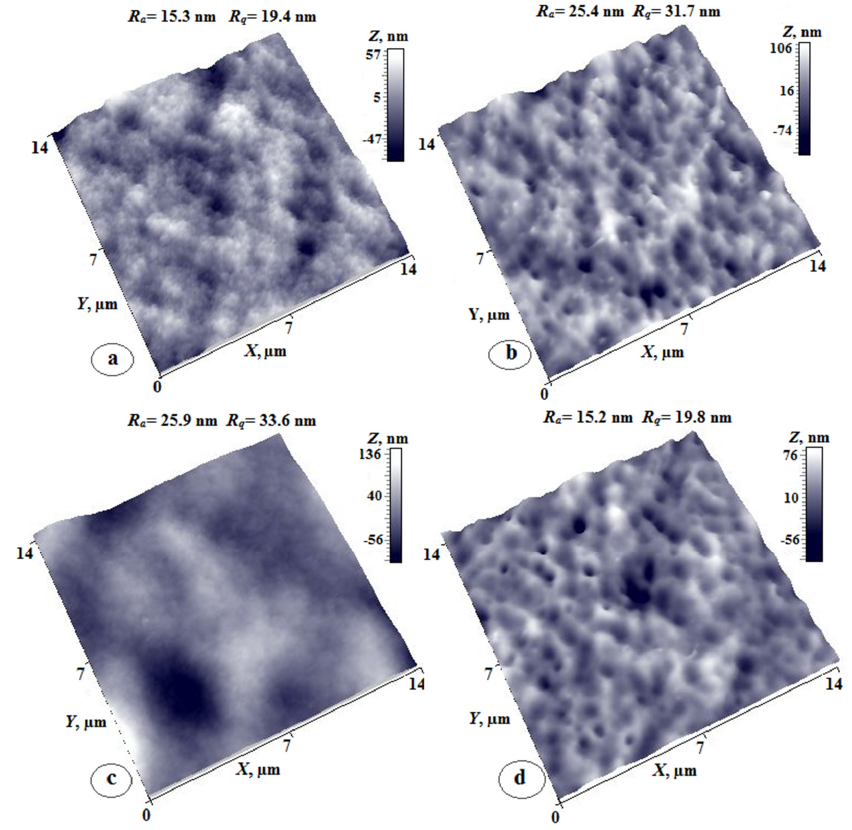
Figure 9. 3D AFM images of surfaces of the coPAI-1 ( a , b ), coPAI-2 ( c , d ) and coPAI-3 ( e , f ) membranes; ( a , c , e )—the upper surface, ( b , d , f )—the substrate-side surface. Thus, the values of the arithmetic mean (Ra) and rms (Rq) surface roughness for co-poly(amide-imide)s PAI-2 (30, 50, and 70%) are equal to 25, 15, 21 nm and 31, 19, 28 nm,